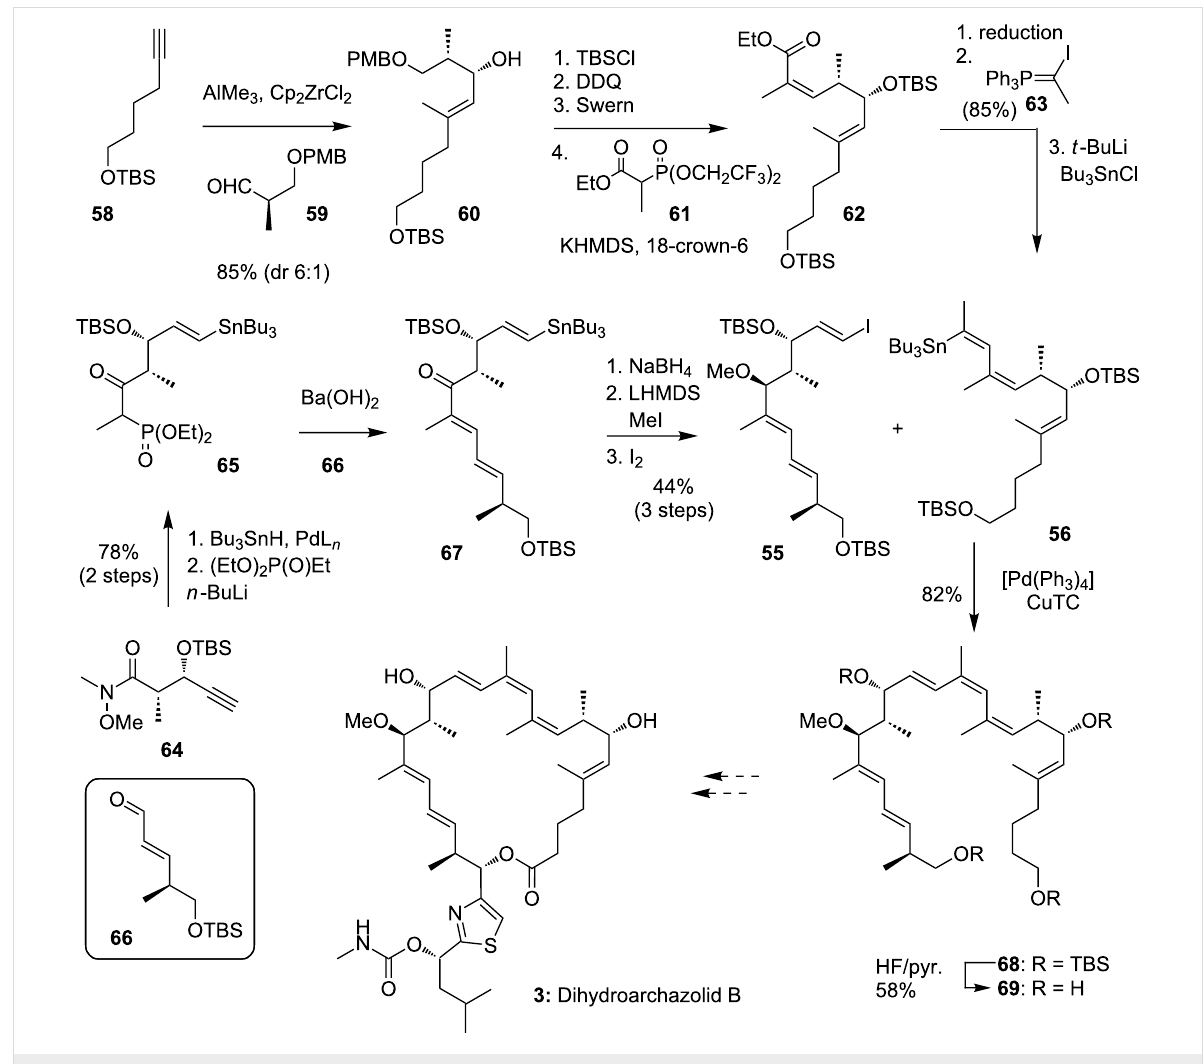
Scheme 13: Fragment synthesis of 69 towards the total synthesis of 3